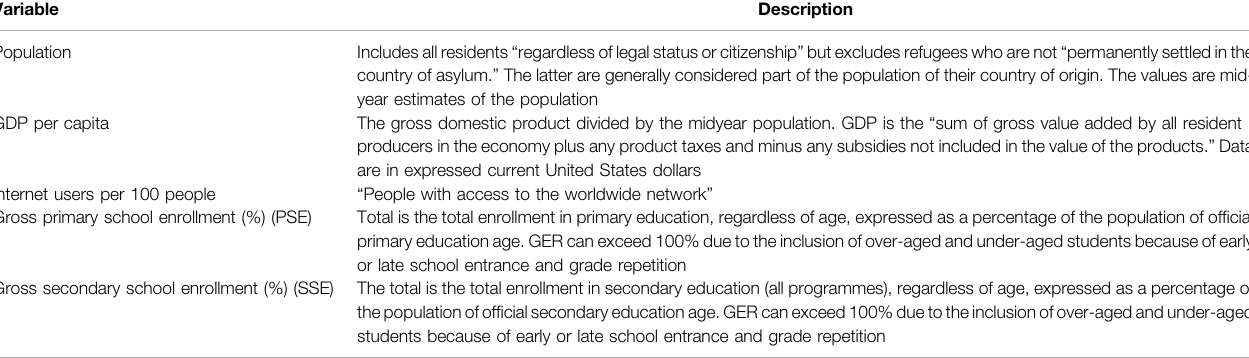
TABLE 1 | Socioeconomic variables Adapted from the World Bank 3 . Variable Description Population